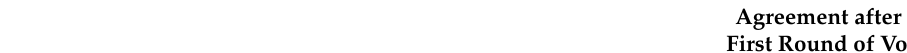
Table 1. Proposed statements regarding the measurement of fecal calprotectin in the management of patients with inflammatory bowel